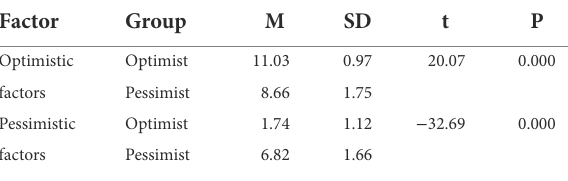
TABLE 1 The difference test of optimism level between optimists and pessimists. Factor Group P Optimistic